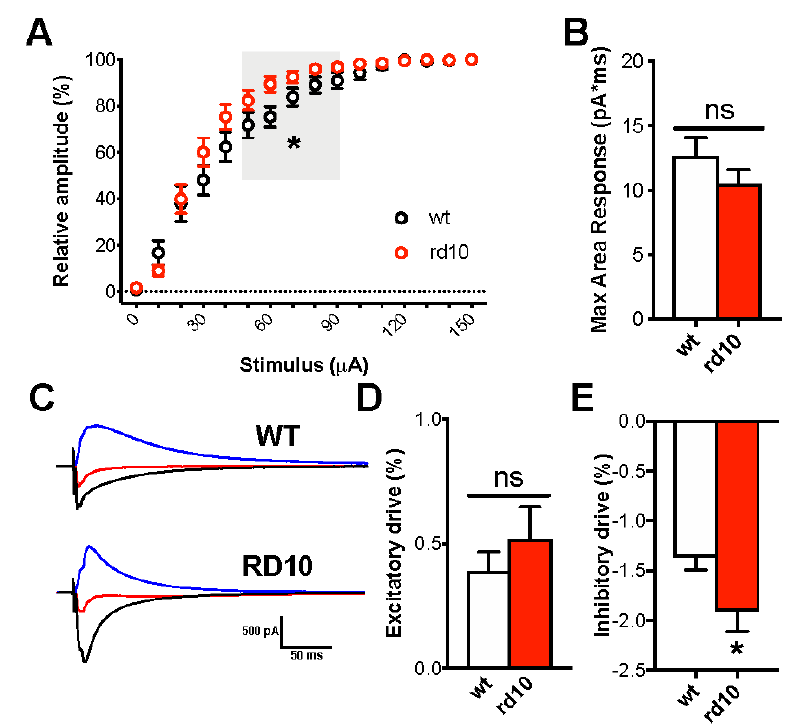
Figure 4. The balance between evoked excitation and inhibition onto pyramidal neurons of layers II/III was altered in rd10 mutants at P60. ( A ) Input–output curves from wt and rd10 single neurons voltage clamped at − 82 mV. Electrical stimulation was provided in layer IV. The percentage relative amplitude as a function of stimulus intensity measured in microampere ( µ A) did show a significant leftward shift in rd10 visual cortex (red circles, n = 17 cells, 9 mice) with respect to wt (black circles, n = 17 cells, 8 mice; two-way RM ANOVA, interaction genotype x stimulus p < 0.01, post hoc Holm–Sidak method p < 0.05 in the 50–90 µ A range). Values are expressed as mean ± s.e.m. percentage change relative to their average maximal amplitude. ( B ) Maximal response area was not significantly different between the two groups ( t -test, p = 0.223). ( C ) Representative recordings of excitatory postsynaptic currents (EPSCs, recorded at the chloride-reversal potential) and inhibitory postsynaptic currents (IPSCs, recorded at the AMPA/NMDA-reversal potential) from pyramidal neurons in slices from P60 wt and rd10 mice. ( D ) The average charge of excitation was not detected in rd10 mutant mice ( n = 17 cells, n = 11 mice for wt and n = 14 cells, n = 12 mice for rd10 animals; Mann–Whitney rank sum test, p = 0.565). ( E ) The average inhibitory drive recorded from the same cells was significantly increased in the rd10 group compared to wt controls ( t -test, p < 0.05). Data are expressed as mean ± s.e.m. * p < 0.05 and ns: not